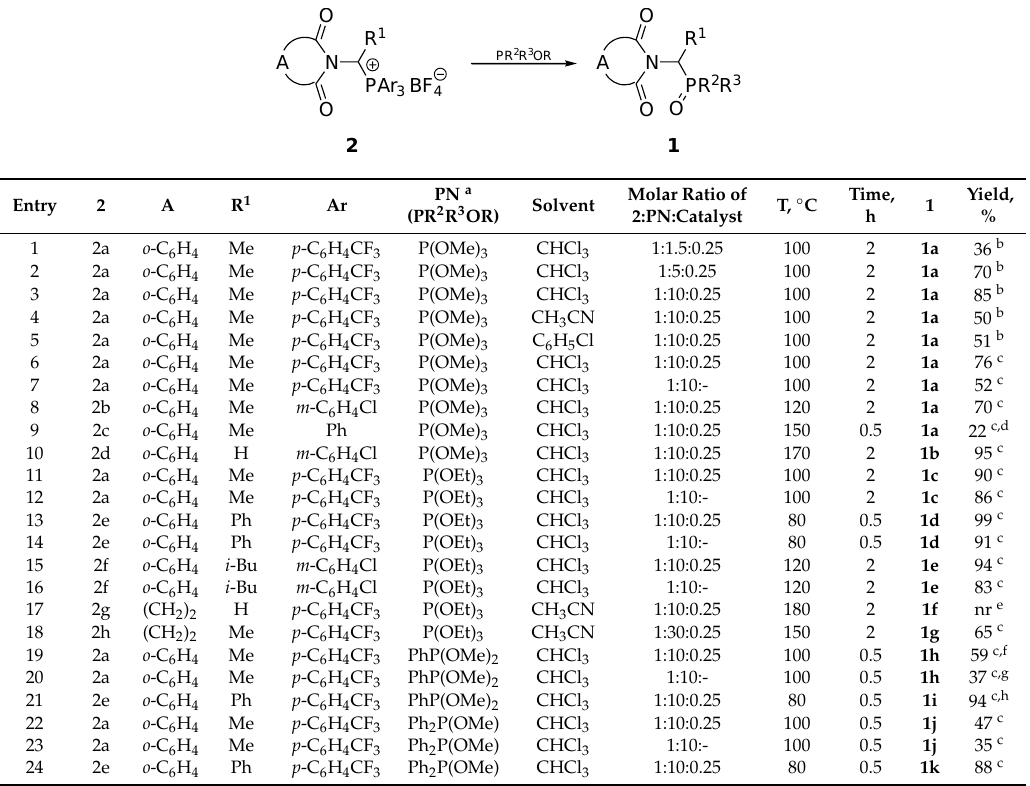
Table 1. Synthesis of 1-imidoalkylphosphonates, 1-imidoalkylphosphinates, and 1-imidoalkylphosphine oxides—conditions and yields.